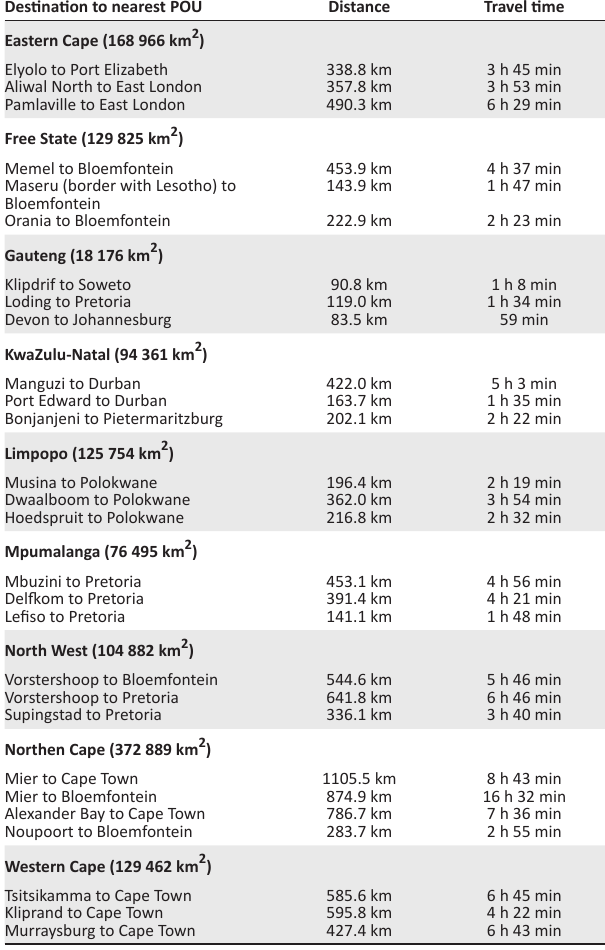
TABLE 7: Provincial distances and traveling times to the nearest paediatric oncology unit during 2000 to 2014. Destination to nearest POU